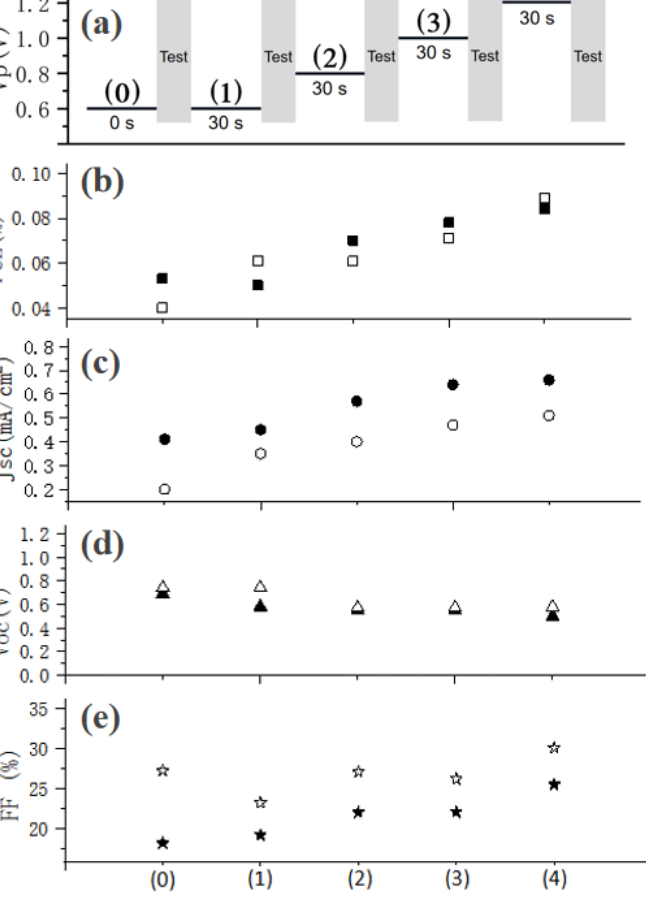
Figure 5. The performance parameters of the optimized device vary with the polarization condition. ( a ) Different polarization conditions; ( b ) the variation trend of PCE with polarization conditions; ( c ) the variation trend of Jsc with polarization conditions; ( d ) variation trend of Voc with polarization conditions; ( e ) the variation trend of FF with polarization